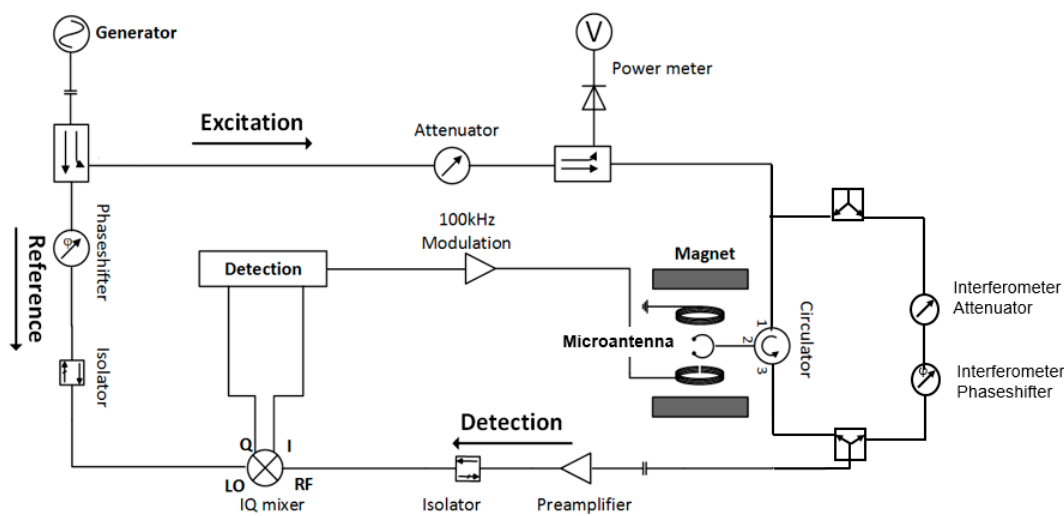
Figure 2. Schematic of the Mach–Zehnder–FMR spectrometer. For broadband measurements, an interferometer arm consisting of two power dividers, variable attenuator, and phase shifter was added parallel to the circulator of the original design [17]. Exchangeable circulators and isolators are used in order to cover a frequency range from 2 to 18 GHz.